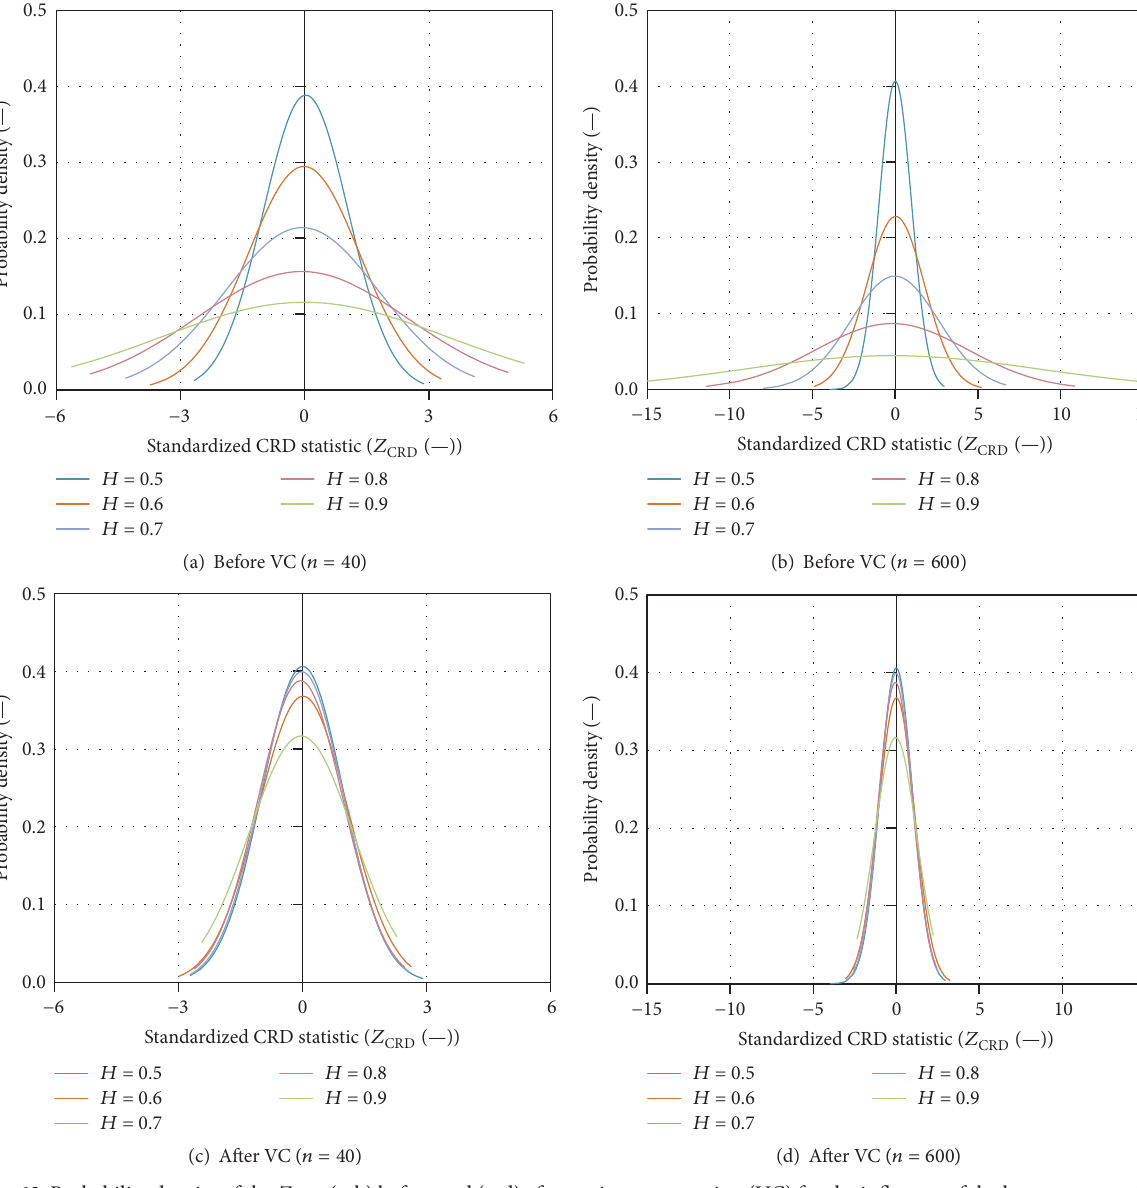
Figure 12: Probability density of the 𝑍 CRD (a-b) before and (c-d) after variance correction (VC) for the influence of the long-term persistence on